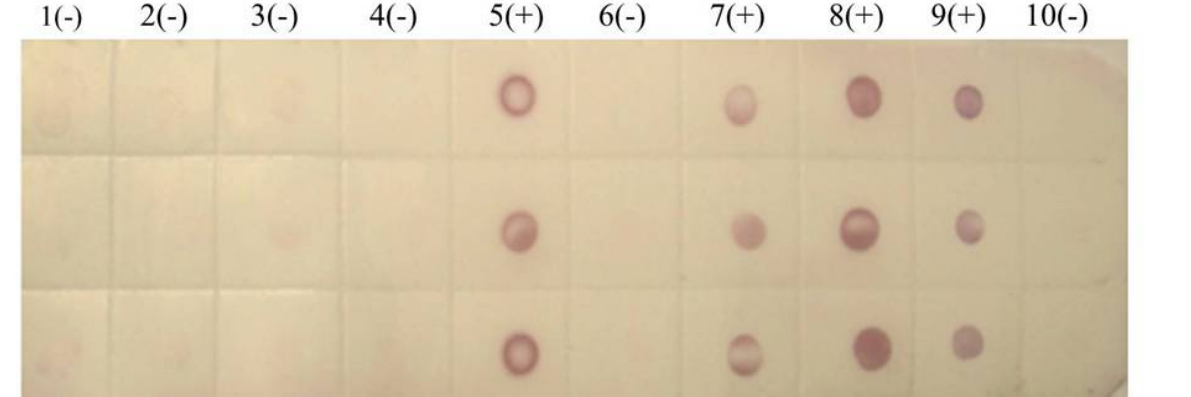
Figure 6. Dot-ELISA test (PVDF membrane) results of suspected rice plants from Yunnan